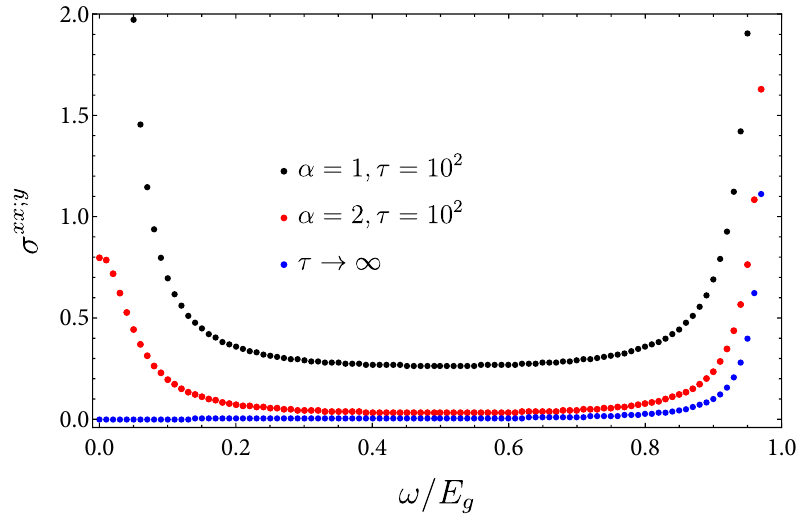
Figure 7: Hall conductivity as a function of frequency in the ω → 0 limit. Black: α = 1 (setting all lifetimes equal). As a result, the transparent region increases (relative to the case of α = 2. A seemingly physical enhancement not showing the characteristic Drude peak appears in the limit ω → 0. Red: α = 2. In this case, the transparent region is more accurately represented (suppressed), and the ω → 0 shows the Drude peak features, in agreement with Ref. [ 31 ] . Blue: τ → ∞ , where only resonant terms are kept. This limit, taken in Refs. [ 5,27 ] does not capture any semiclassical contributions. The total conductivity is calculated within the model of Eq. (C.1), with the parameters A = 0.5, B = 0.2, C = 0, M = 3.5. The Fermi level is set to µ = − 1.0, and a finite Fermi surface